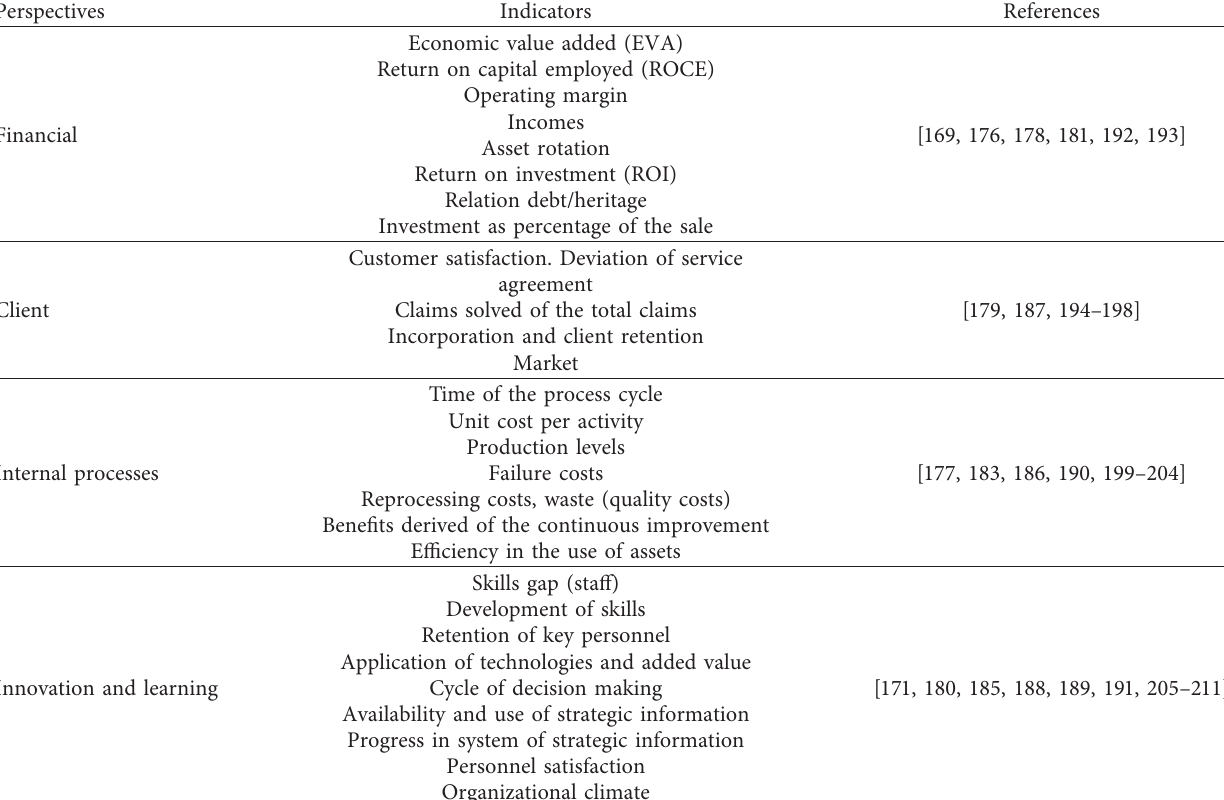
Table 8: Main BSC indicators and classification of investigations – strategic evaluation